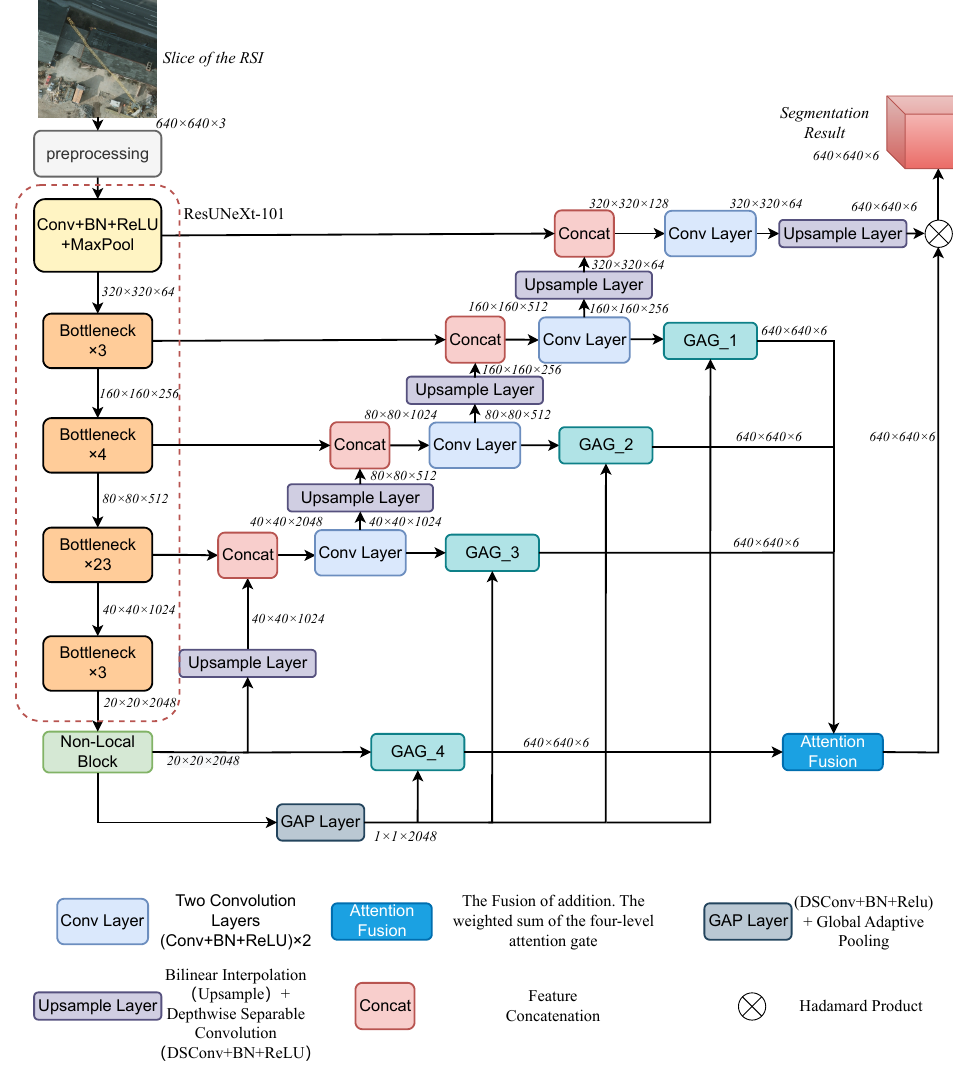
Figure 2. Schematic of the